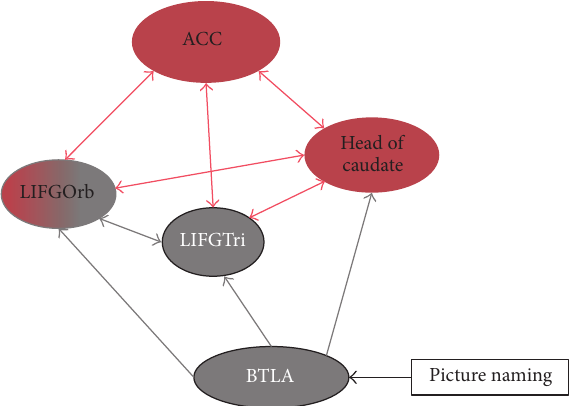
Figure 2: The structure of language-control network. This network was proposed by Abutalebi et al. (2009). Connections between brain areas involved in picture naming (in black) and control (in red). The modulatory effect of the experimental task (picture naming in L1 and L2) was added to the model on BTLA. ACC: anterior cingulate cortex, LIFGTri: left inferior frontal gyrus-pars triangularis, LIFGOrb: left inferior frontal gyrus-pars orbitalis, BTLA: basal temporal language